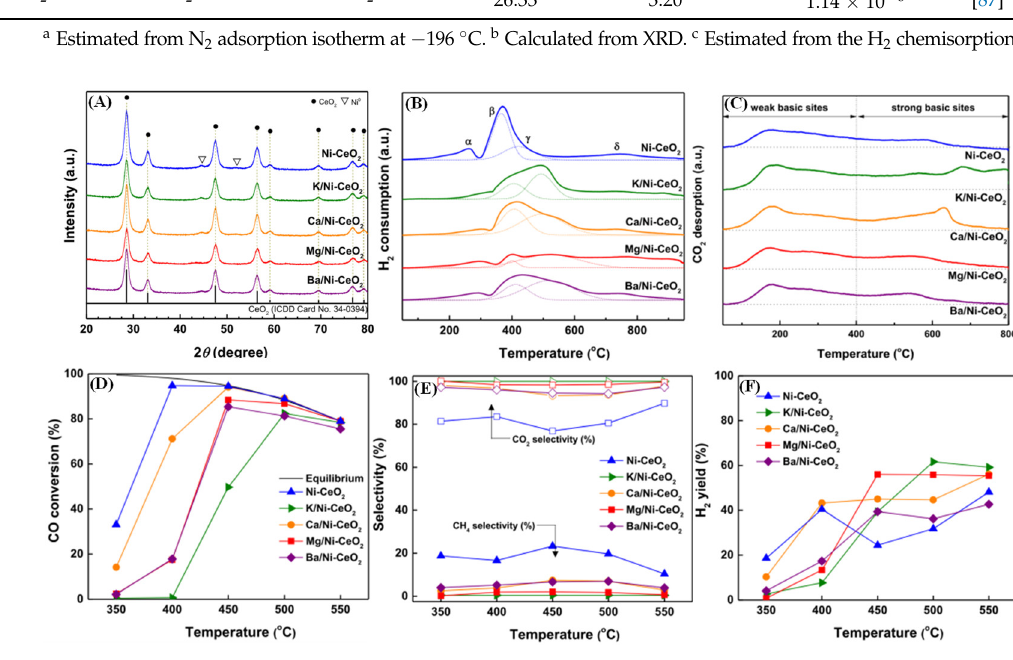
Figure 6. ( A ) XRD patterns of Ni-based catalysts; ( B ) H 2 -TPR of Ni-based catalysts; ( C ) CO 2 -TPD patterns of Ni-based catalysts; ( D ) CO conversion of Ni-based catalysts. ( E ) Selectivity to CH 4 and CO 2 of Ni-based catalysts; ( F ) H 2 yield of Ni-based catalysts. Adapted from Ref. [87]. Copyright 2022 Elsevier. Table 7. Characteristics of Ni-based catalysts.